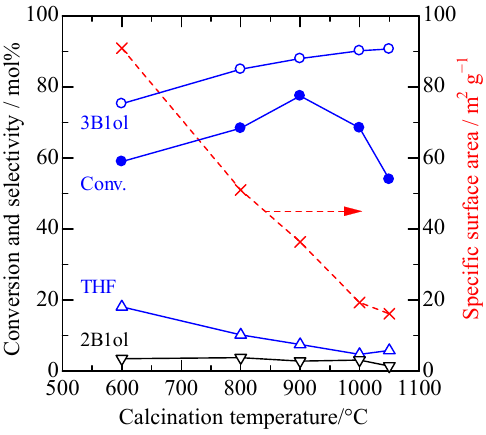
Figure 6. E ff ect of calcination temperature of YZrO catalyst on the dehydration of 1,4-BDO and SA .